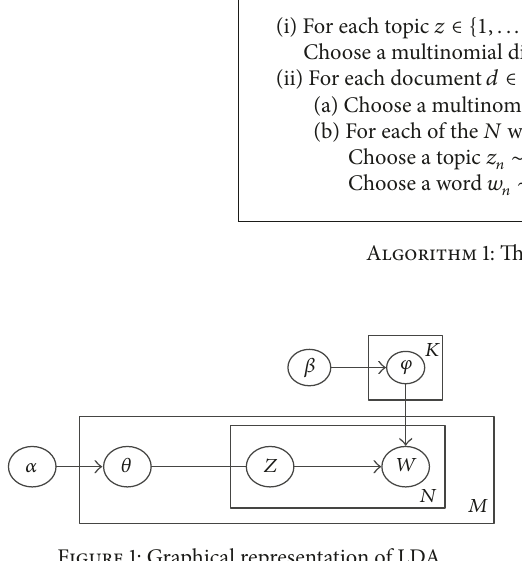
Figure 1: Graphical representation of